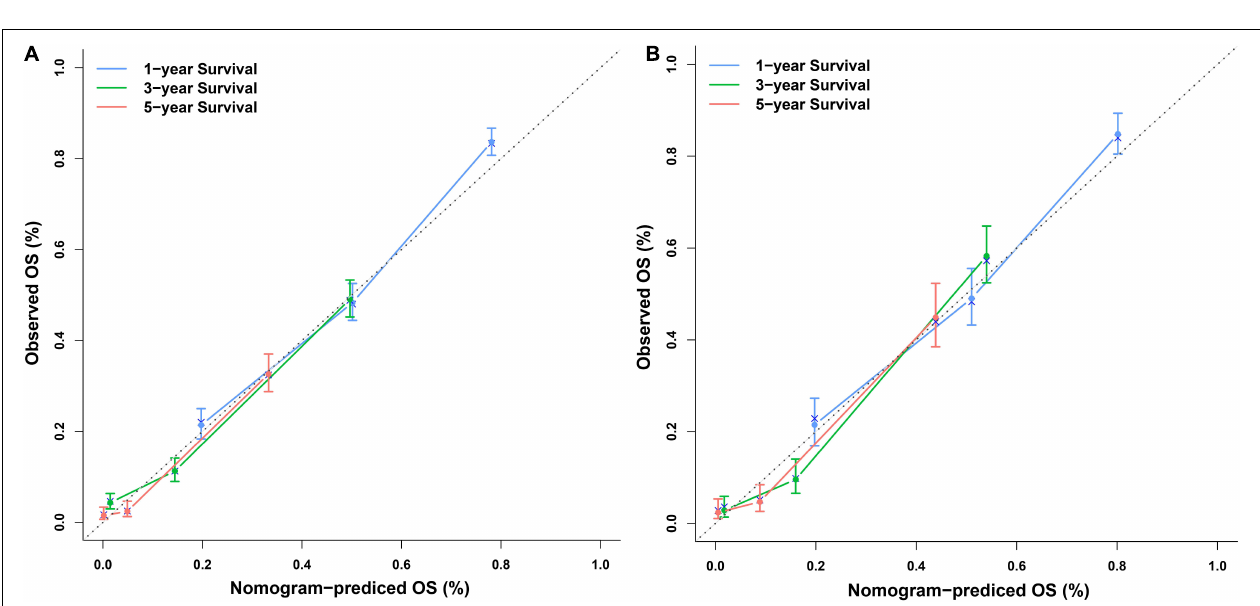
FIGURE 10 | Calibration plots of the nomogram. (A) Calibration plots of the 1-, 3-, and 5-year OS in the training dataset. (B) Calibration plots of the 1-, 3-, and 5-year OS in the testing dataset.